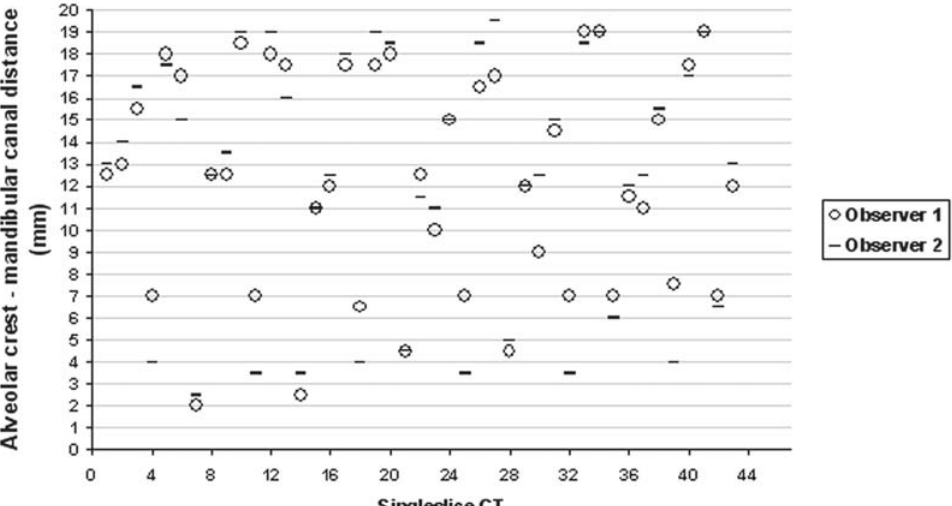
FIGURE 2- Measurements (in mm) from the alveolar crest to the mandibular canal roof obtained by the observers in single- slice CT (partial sample)